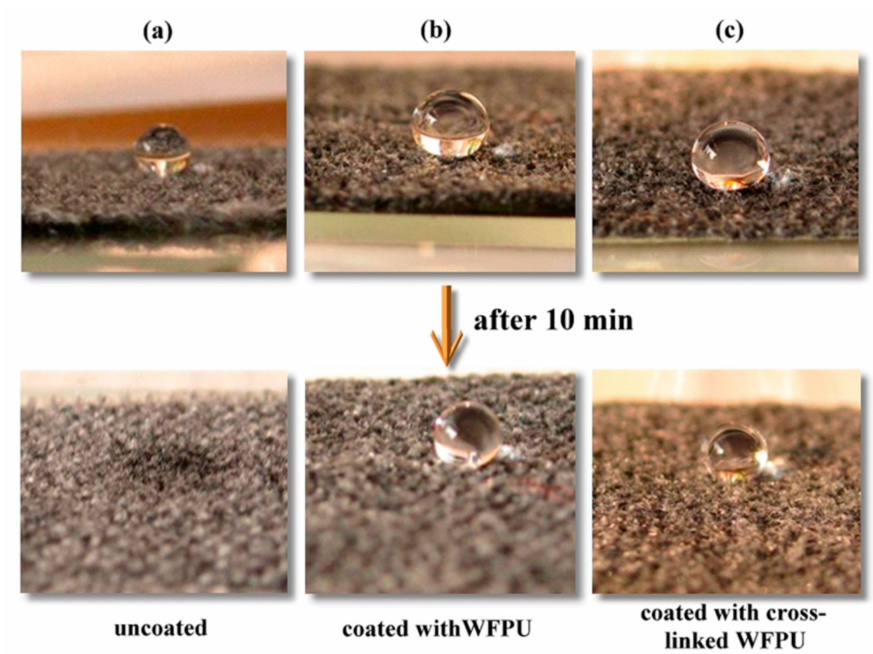
Figure 9. Photographs of cottons absorbing water droplets. Key: ( a ) uncoated; ( b ) coated with WFPU; and, ( c ) coated with the cross-linked WFPU [42]. Copyright © (2014) American Chemical Society.